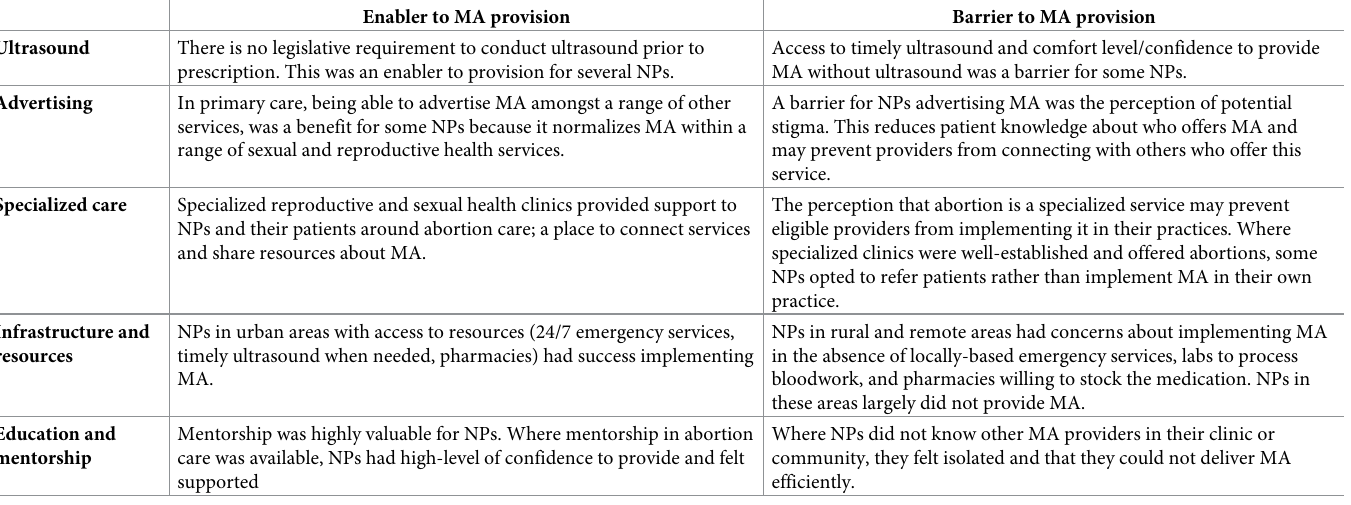
Table 1. Summary of key enablers and barriers to NP provision of medication abortion in Canada. Enabler to MA